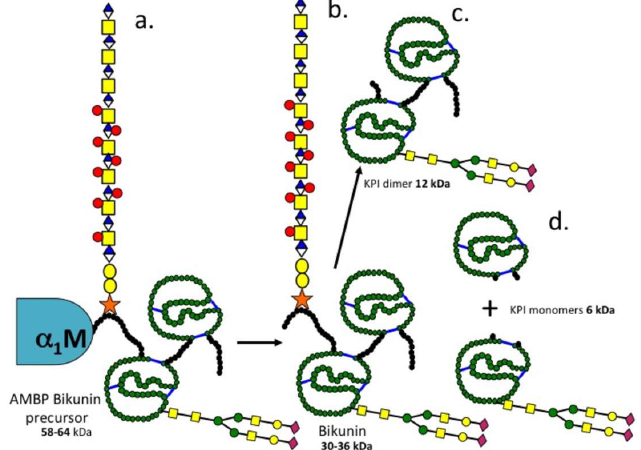
Figure 8. Schematic representations and proposed inter relationship between SPI species seen in this study. a. α1 microglobulin-bikunin precursor (58–64 kDa), b. bikunin 30–36 kDa, c. bikunin KPI dimer (12–16 kDa) after removal of the 11.7 kDa CS chain from bikunin, d. bikunin KPI monomers (6–9 kDa) with the N-linked 2–4 kDa glycan oligosaccharide attached to the KPI-1 domain which facilitates its isolation by ConA affinity chromatography and the 6 kDa KPI-2 domain which does contain oligosaccharide